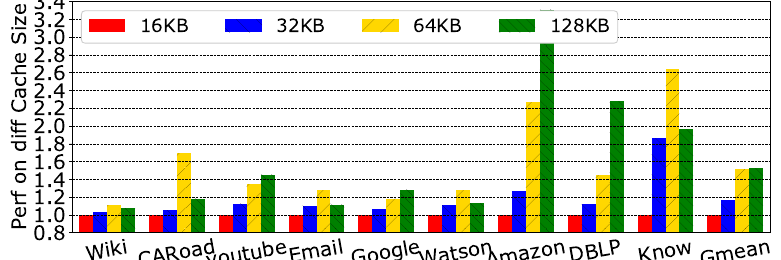
Figure 13. Comparison of the performance for different on-chip cache